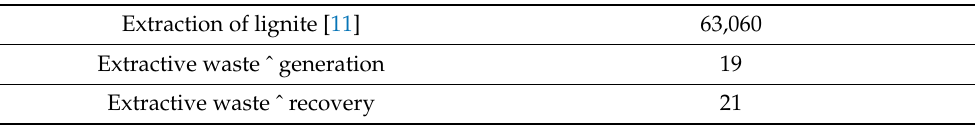
Table 1. PGE G ó rnictwo i Energetyka Konwencjonalna S.A., Bełchat ó w—extraction of lignite and reported waste, ths. tons,